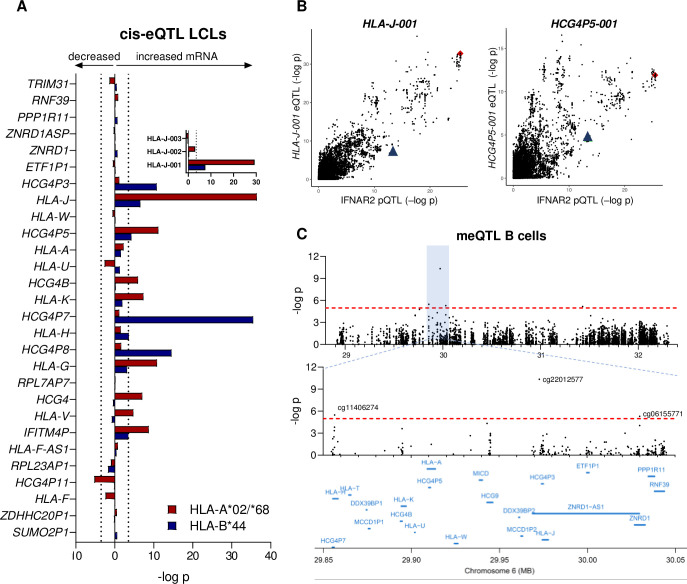
The MS-protective class I alleles are cis-eQTLs of HLA-J.(A) Cis-eQTL analysis within ± 1 Mb from the HLA-A*02/A*68 and HLA-B*44 tag SNPs in LCLs (n = 373). The p-value threshold of p < 3.2E-4, corresponding to a Bonferroni adjusted p-value of < 0.05 (155 analysed genes) is denoted with dotted lines. Data for 28 of the 155 genes are shown. The inset shows the transcript specific cis-eQTL p-values of HLA-J. (B) Correlation between p-values from the IFNAR2 pQTL in B cells and the cis-eQTL in LCLs for the transcript HLA-J-001 (left) and HCG4P5-001 (right). The HLA-A*02/A*68 and the B*44 tagging SNPs are marked in red and blue respectively. (C) Cis-meQTL analysis of the HLA-A*02/A*68 tagging SNP rs2735099 in primary B cells (n = 43). The p-value threshold of p < 2.1E-6, corresponding to a Bonferroni adjusted p-value of < 0.05 (23, 722 analysed CpG-sites) is denoted with dotted red lines.